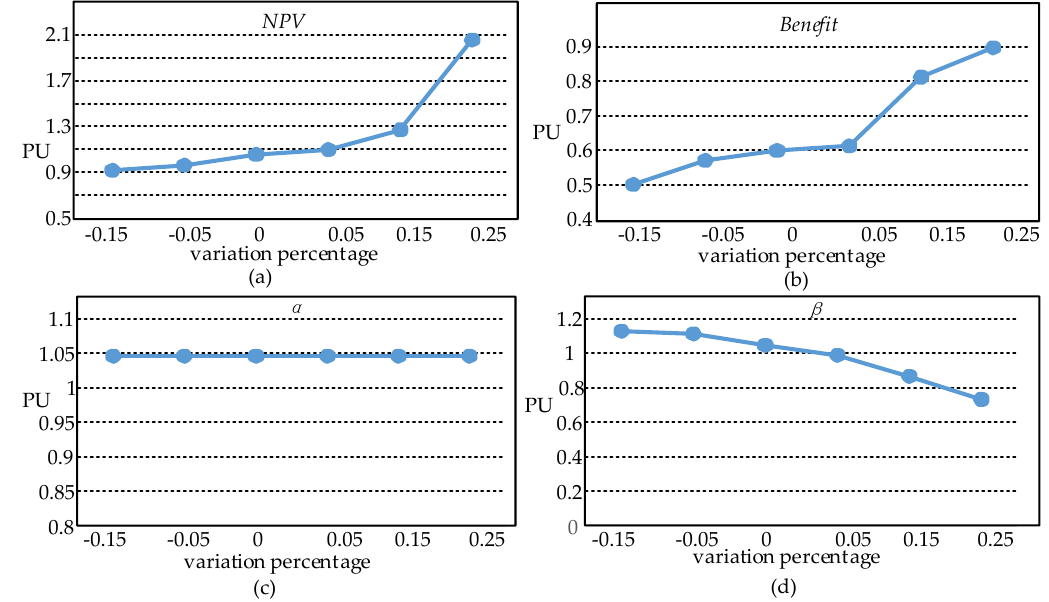
Figure 13. The effect of parameters on PU, ( a ) is the effect of NPV variation on PU of customer L 1 , ( b ) is the effect of Benefit on PU of NERC, ( c ) is the effect of disappointment parameter variation on PU of customer L 1 , ( d ) is the effect of rejoicing parameter variation on PU of customer L 1 .